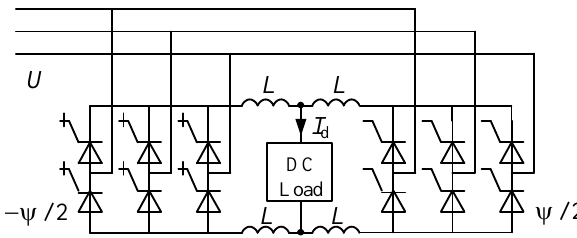
Fig. 2. Simplest circuit diagram of 12-pulse rectifier with electronic phase shifting.